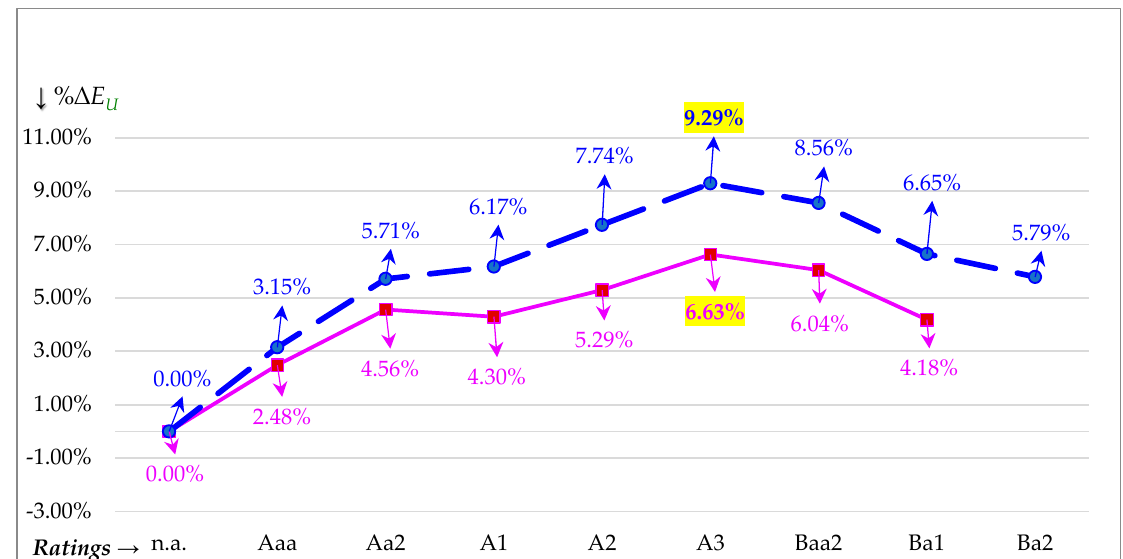
Figure 4. % Δ E U values are plotted along vertical axis against Moody’s credit ratings along horizontal axis. % Δ E U is G L as a percent of unlevered equity ( E U ). The nonprofit trajectory is the solid line and the pass-through trajectory is the dashed line. We use credit spreads for 2019, TCJA low ( L ) tax rates, and 3.12% growth where the growth ( RE ) constraint sets in after Ba1 for nonprofits (NPs) and after Ba2 for pass-throughs (PTs). The optimal credit rating ( OCR ) is A3.